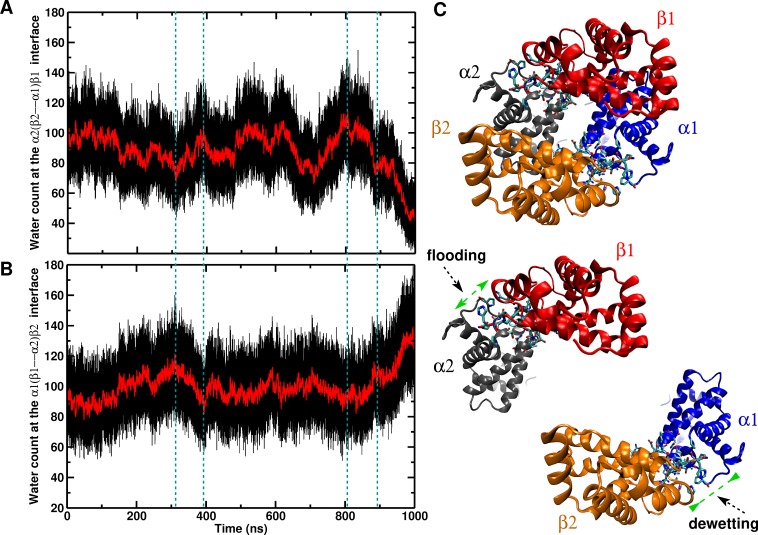
Water at the (α1β2):(α2β1) interface.The number of water molecules at the (α1β2):(α2β1) interface from 1 μs MD for the 90 Å box. (A) Time series of the β1:α2 interface. (B) Time series of the β2:α1 interface. (C) Illustration of the studied regions. The transitions occur at 480, 780 and 880 ns, respectively.